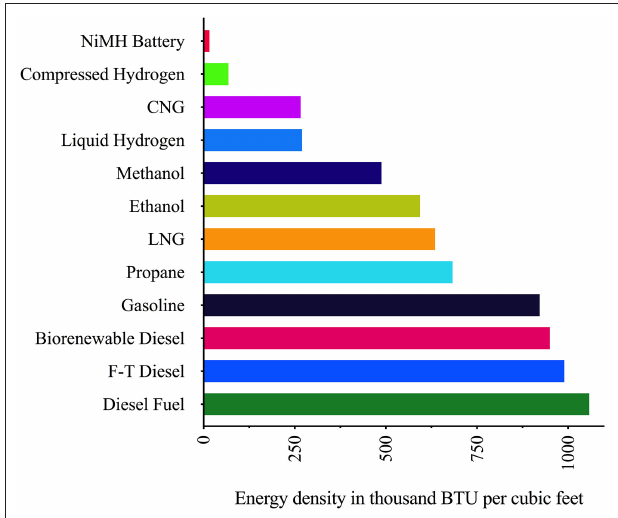
FIGURE 1 | Energy density of different fuels and energy storage options. Data Source: U.S. Department of Energy (Eberhardt,